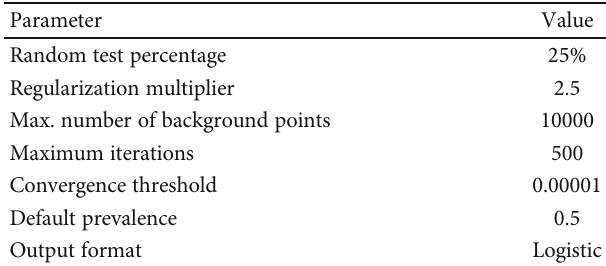
Table 4: MaxEnt parameters used in the Jiamacase